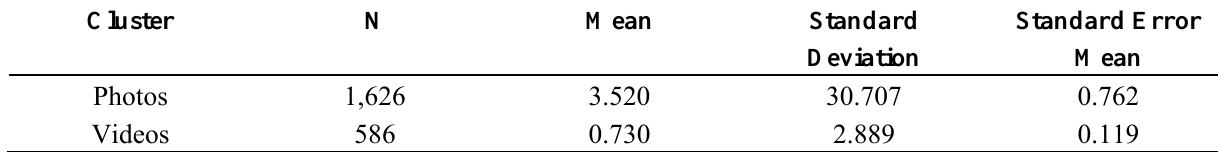
Table 3. Descriptive statistics of our sample.